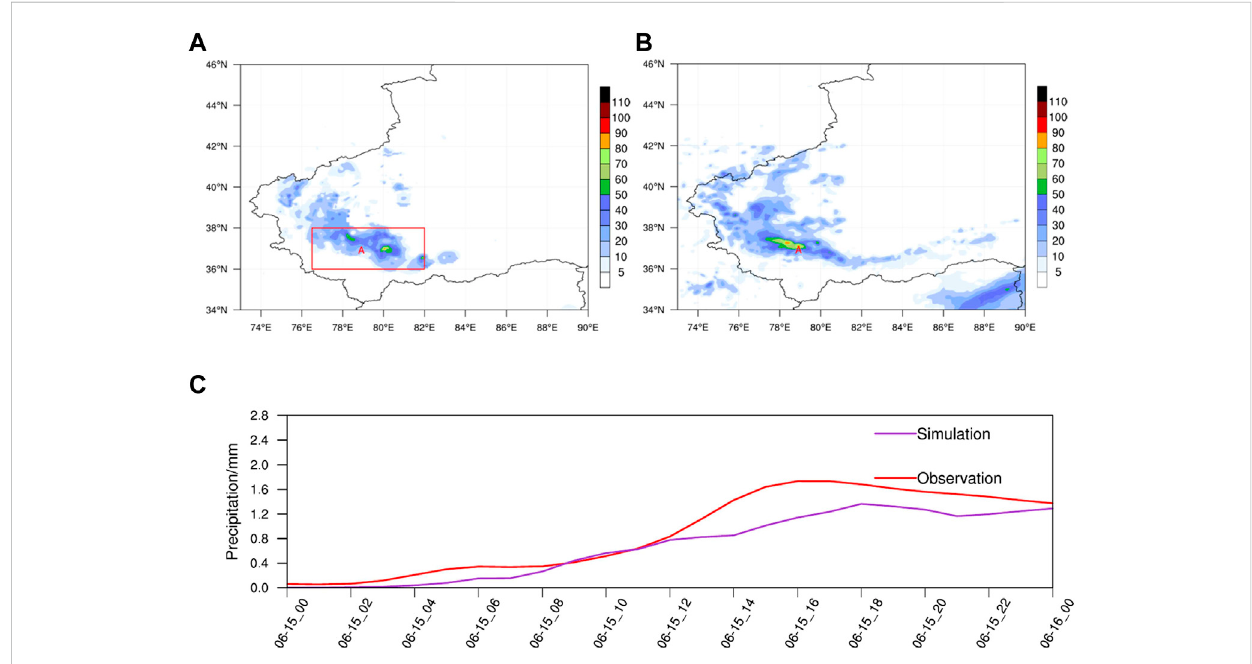
FIGURE 3 (A) Observed and (B) simulated 24-h accumulated precipitation (units: mm) at 0000 UTC on 16 June 2021 and (C) time series of the simulated and observed domain-mean hourly precipitation. The red rectangular box in panel a denotes thearea where thedomain-mean value was calculated in panel (C) . The “ A ” labels in panels (A, B) denote the convection initiation